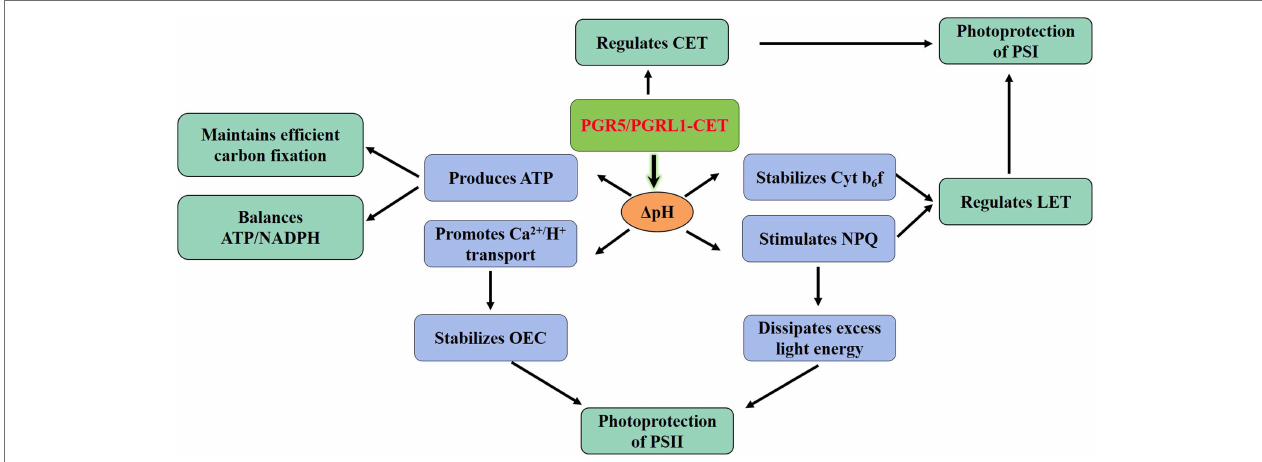
FIGURE 2 | Physiological functionality of the PGR5/PGRL1-dependent CET. The PGR5/PGRL1-mediated CET produces more ATP by increasing Δ pH to balance ATP/NADPH and meeting the requirements for efficient C fixation. Meanwhile, the increase of Δ pH would protect the PSII from photoinhibition via stimulating the NPQ and facilitating the transport of Ca 2+ /H + . ATP, adenosine triphosphate; CET, cyclic electron transport; Cytb 6 f, cytochrome b 6 f complex; LET, linear electron transport; NADPH, reduced nicotinamide adenine dinucleotide phosphate; NPQ, non-photochemical quenching; OEC, oxygen-evolving complex; PGR5, proton gradient regulation 5; PGRL1, PRG5-like photosynthetic phenotype 1; PSI, photosystem I and PSII, photosystem